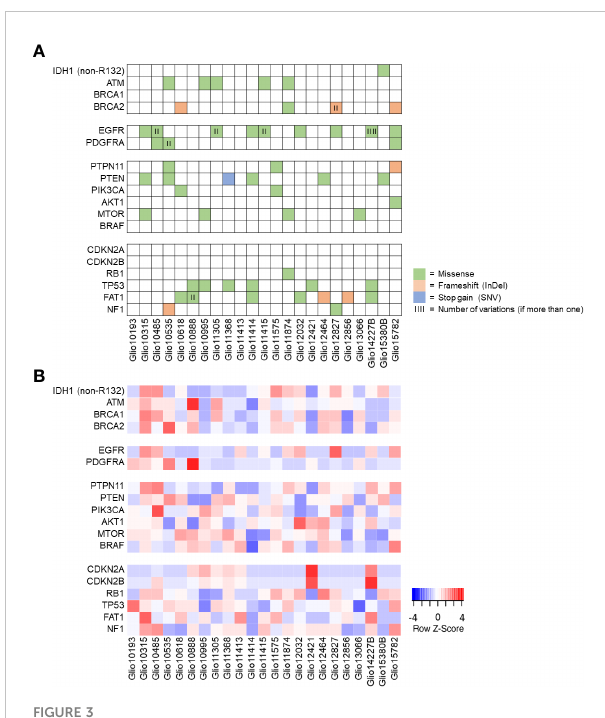
FIGURE 3 Mutation status of selected genes and their expression in GBM PDX models. (A) Using available RNA sequencing data, a selection of genes frequently mutated in GBM was analyzed for mutations in our panel of GBM PDX, revealing PDX individual pro fi les. (B) Expression of the genes listed, with comparably high EGFR expression in most PDX bearing EGFR